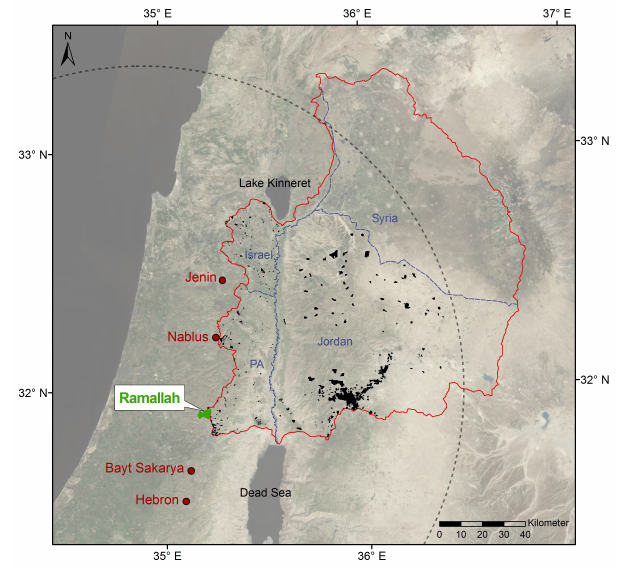
Fig. 1. Location Map: the multi-national Lower Jordan River Basin with its urban areas (black) and the city of Ramallah (green); in red: meteorological stations with available data for measured evapora- tion; circle indicates the 150km range around the rainfall radar.